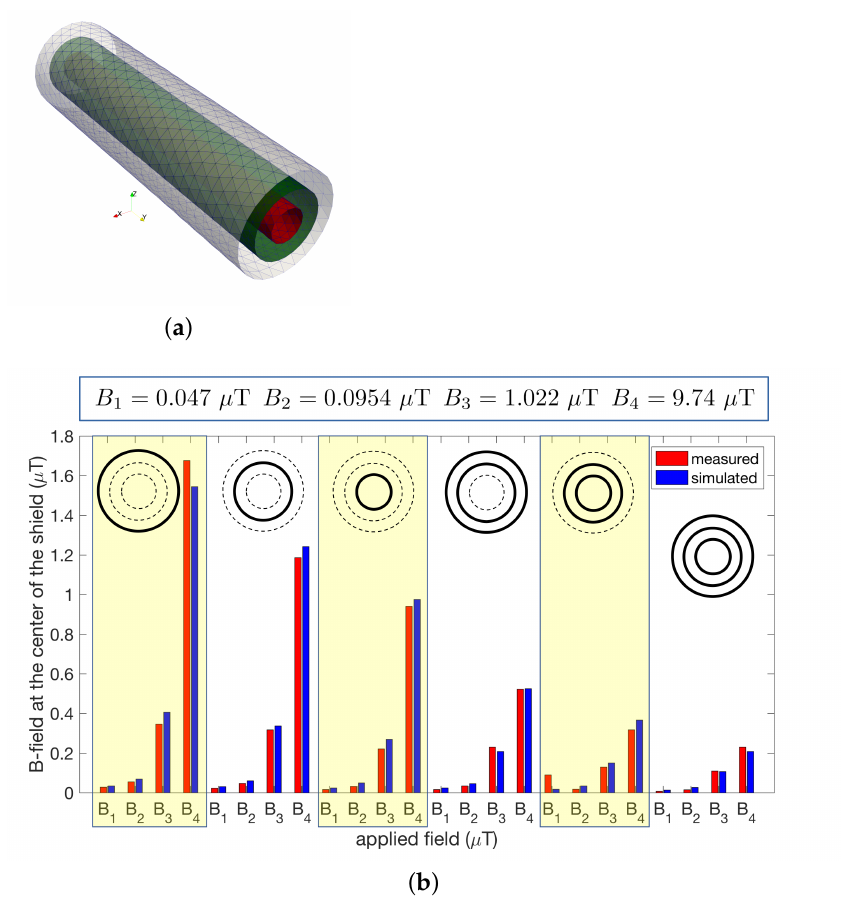
Figure 7. Shield configuration adopted to test the identification robustness ( a ). Comparison of measured and simulated magnetic flux density at the center of the shield for different external field values and layer configurations ( b